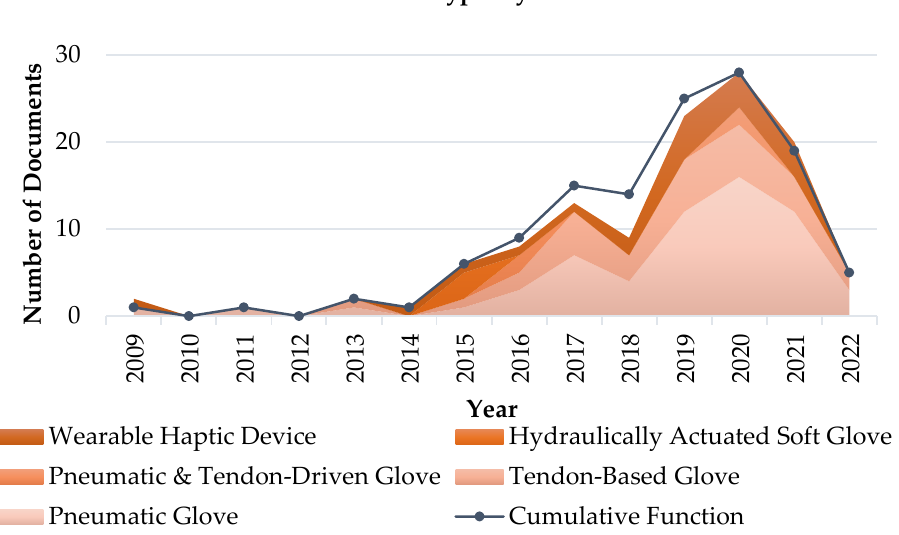
Figure 16. Evolution in time of the soft gloves with respect to the device type. Data are presented in stacked format, with the total amount of documents for each year in black line with